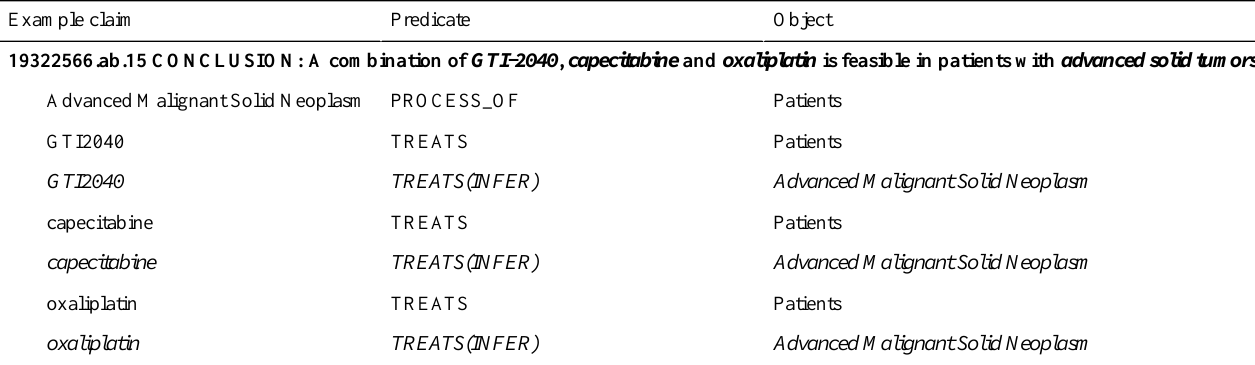
Table 2. Examples of SemRep semantic predications based on a biomedical claim. ObjectPredicateExample